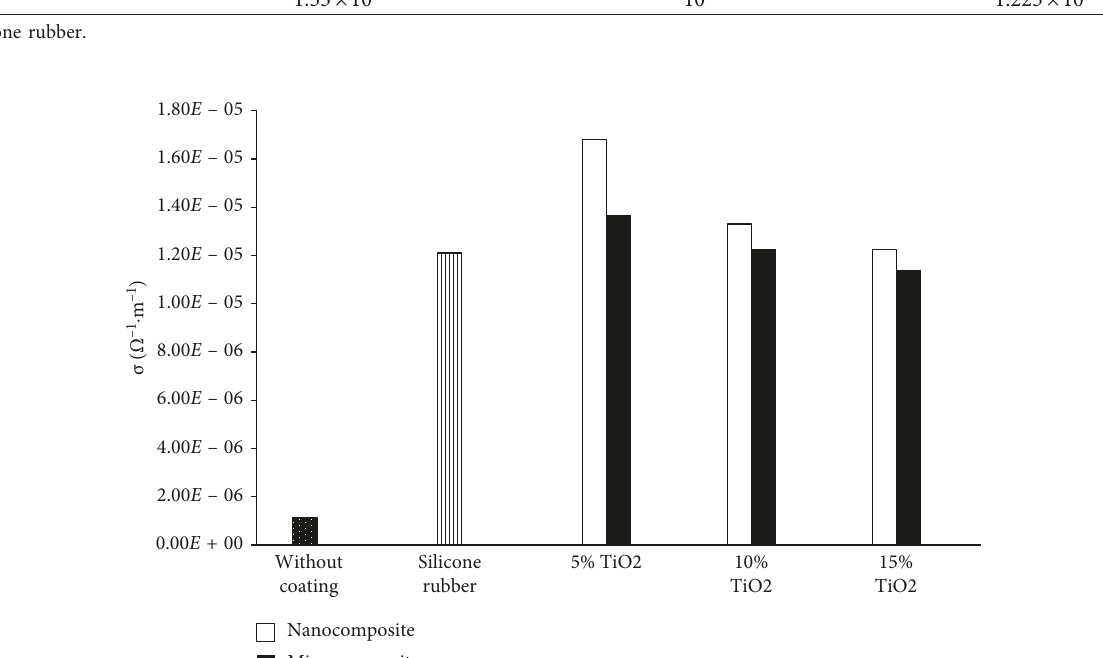
Figure 7: Evolution of the electrical conductivity of the microcomposites and nanocomposites based on the concentration of TiO